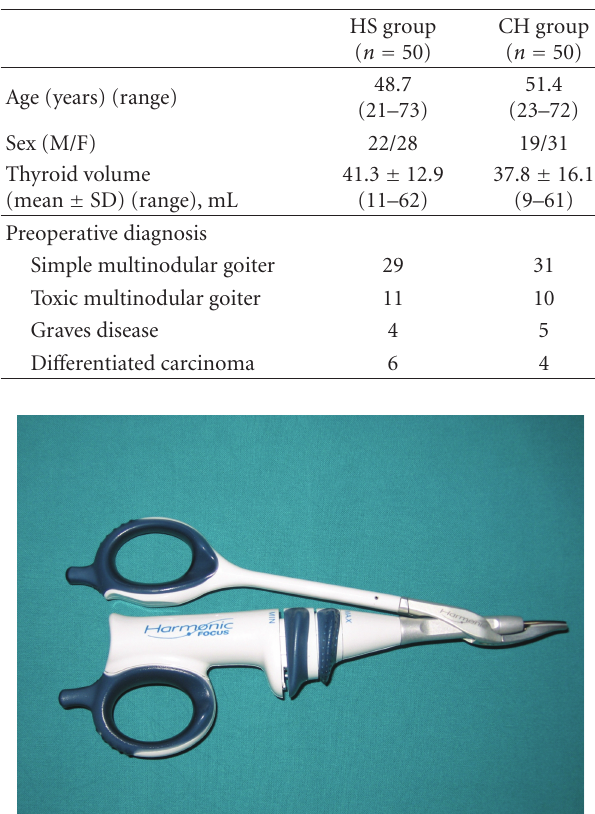
Table 1: Demographic characteristics and preoperative diagnosis in HS (Harmonic Scalpel) and CH (Conventional Hemostasis) groups.